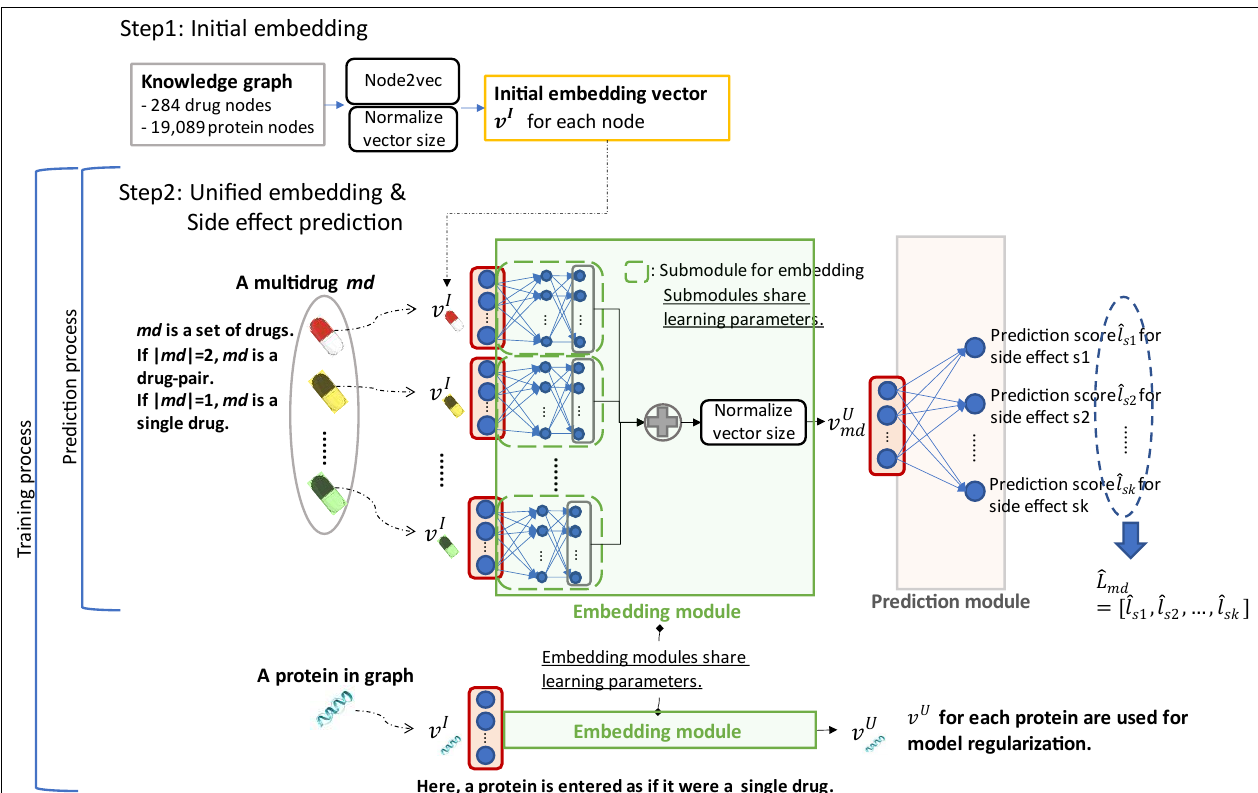
Figure 2. Overall structure of the proposed method for multidrug side effects prediction. For a given multidrug, the model yields an embedding vector representing this multidrug and generates its prediction scores for k targeted side effects from this vector.